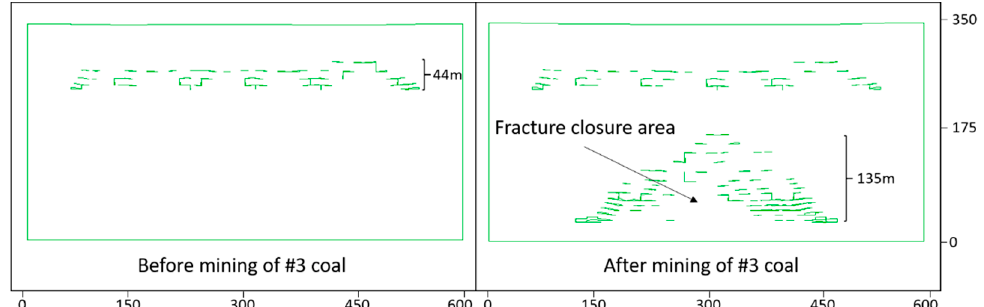
Figure 10. Comparison diagram of fracture distribution of overlying rock before and after mining of # 3 coal.